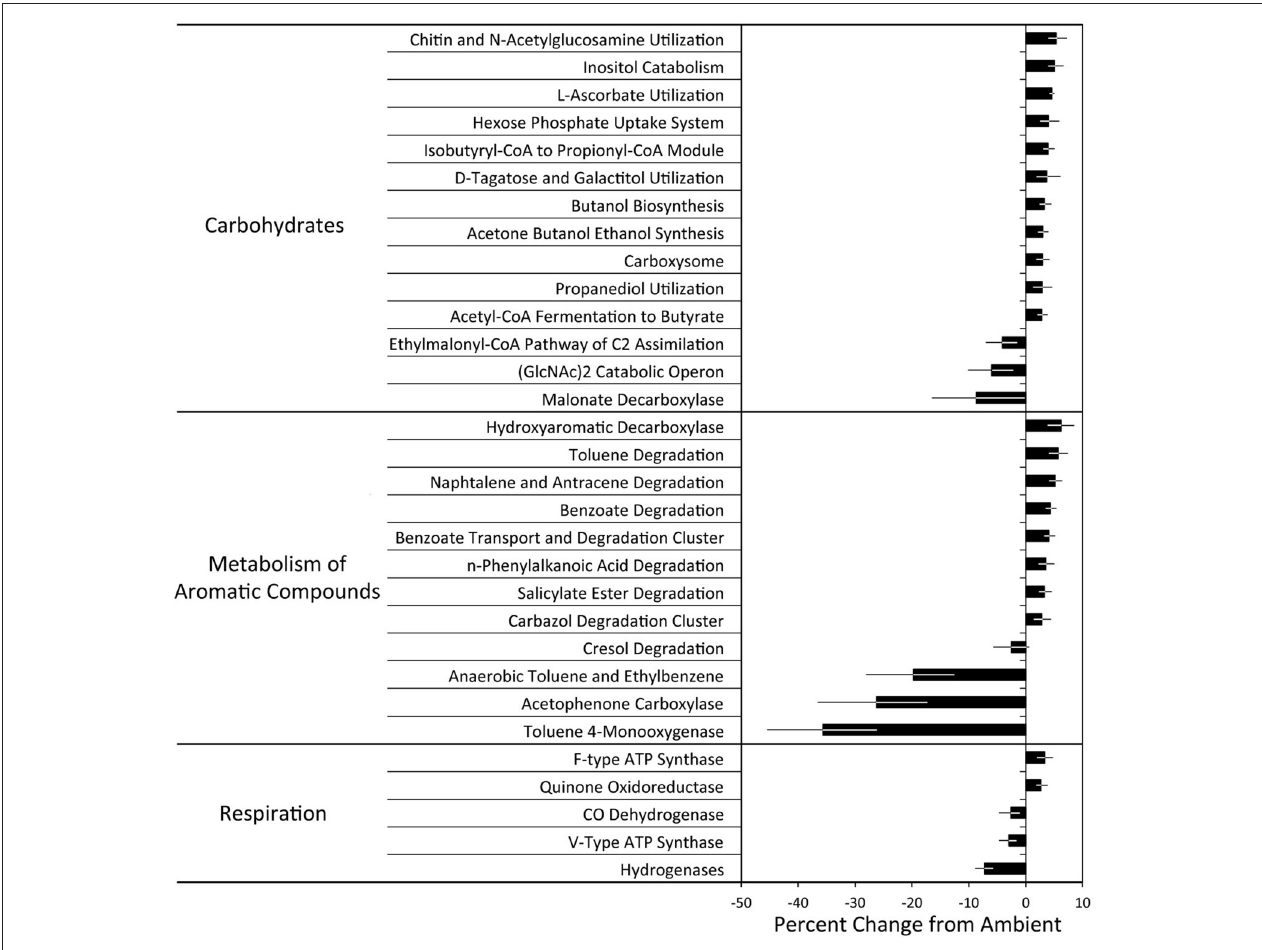
FIGURE 2 | The effect of experimental N deposition on the relative abundance of SEED subsystem level 3 functional pathways. All pathways presented were significantly different in abundance and exhibited a greater than ± 2.5% change between the ambient and experimental N deposition treatment (adjusted P